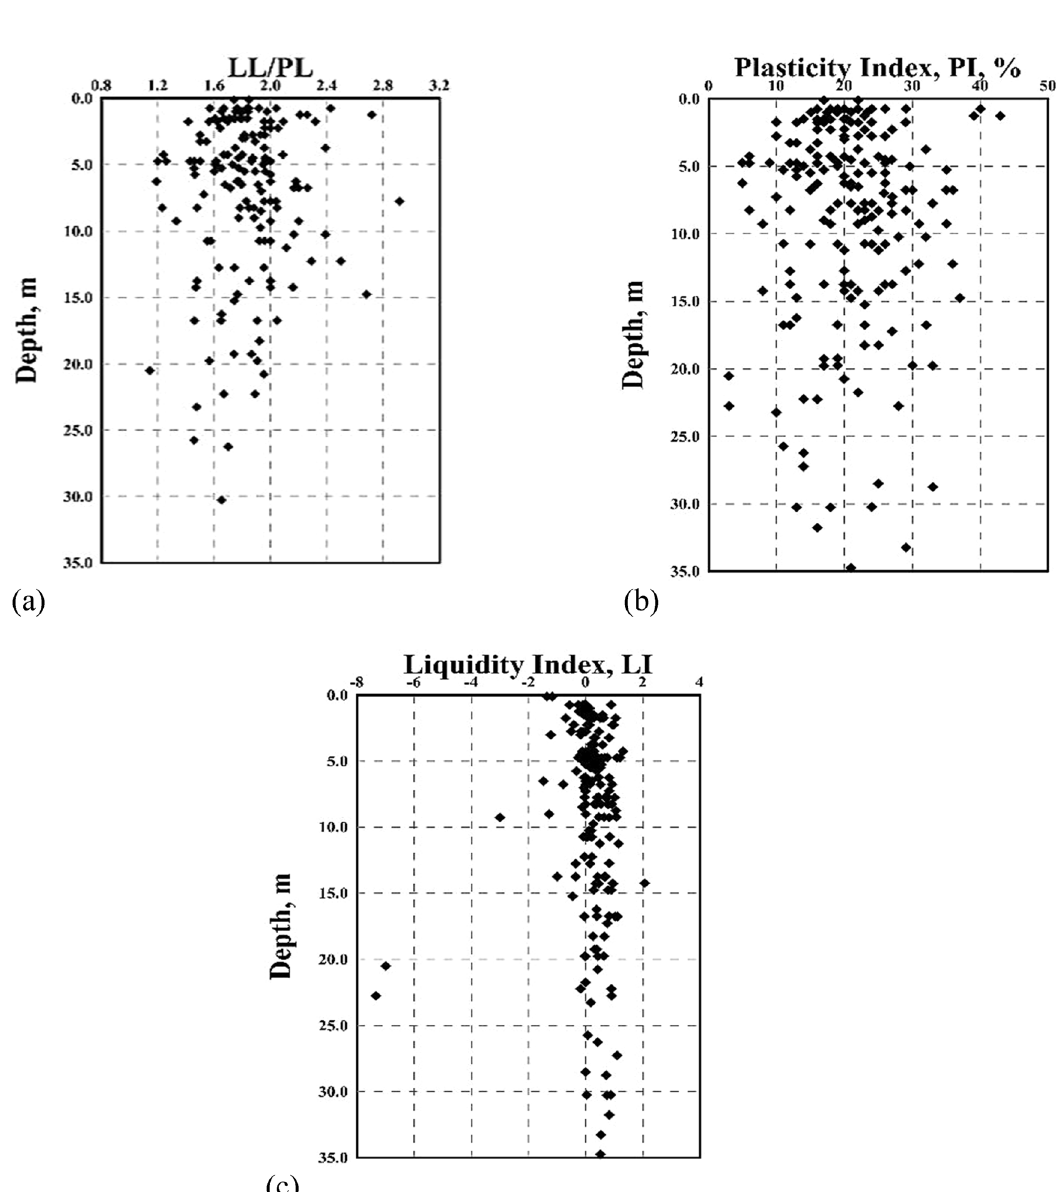
Figure 5: Variation of the Atterberg limits and LI with depth: ( a ) LL/PL, ( b ) PI ( % ) , and ( c )